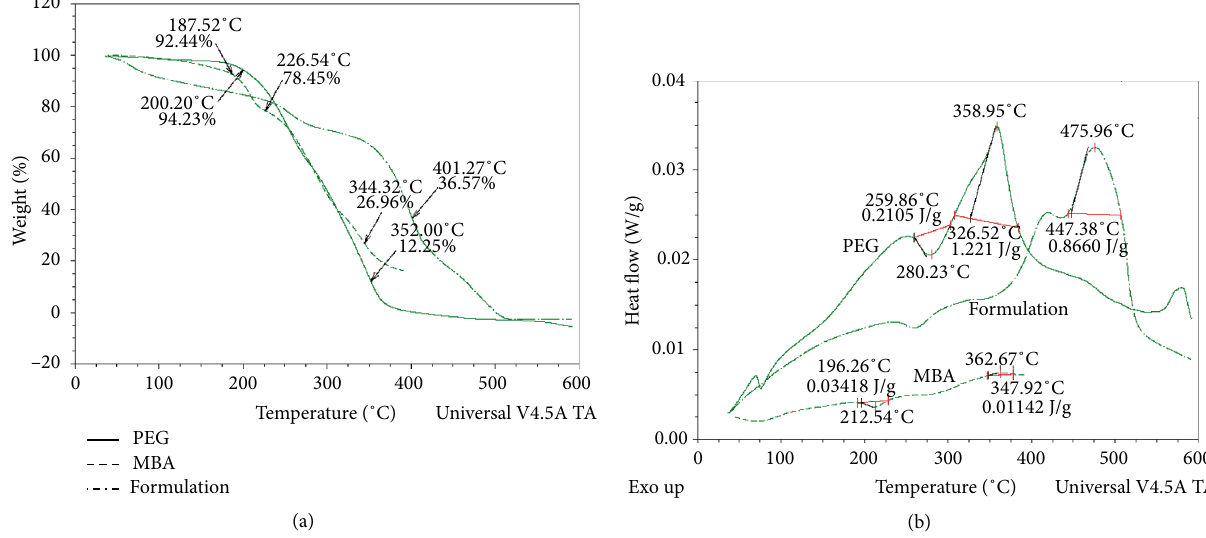
Figure 6: (a) TGA thermogram of PEG-6000, MBA, and PEG-g-poly (MAA) nanogels. (b) DSC thermogram of PEG-6000, MAA, and PEG-g-poly (MAA).